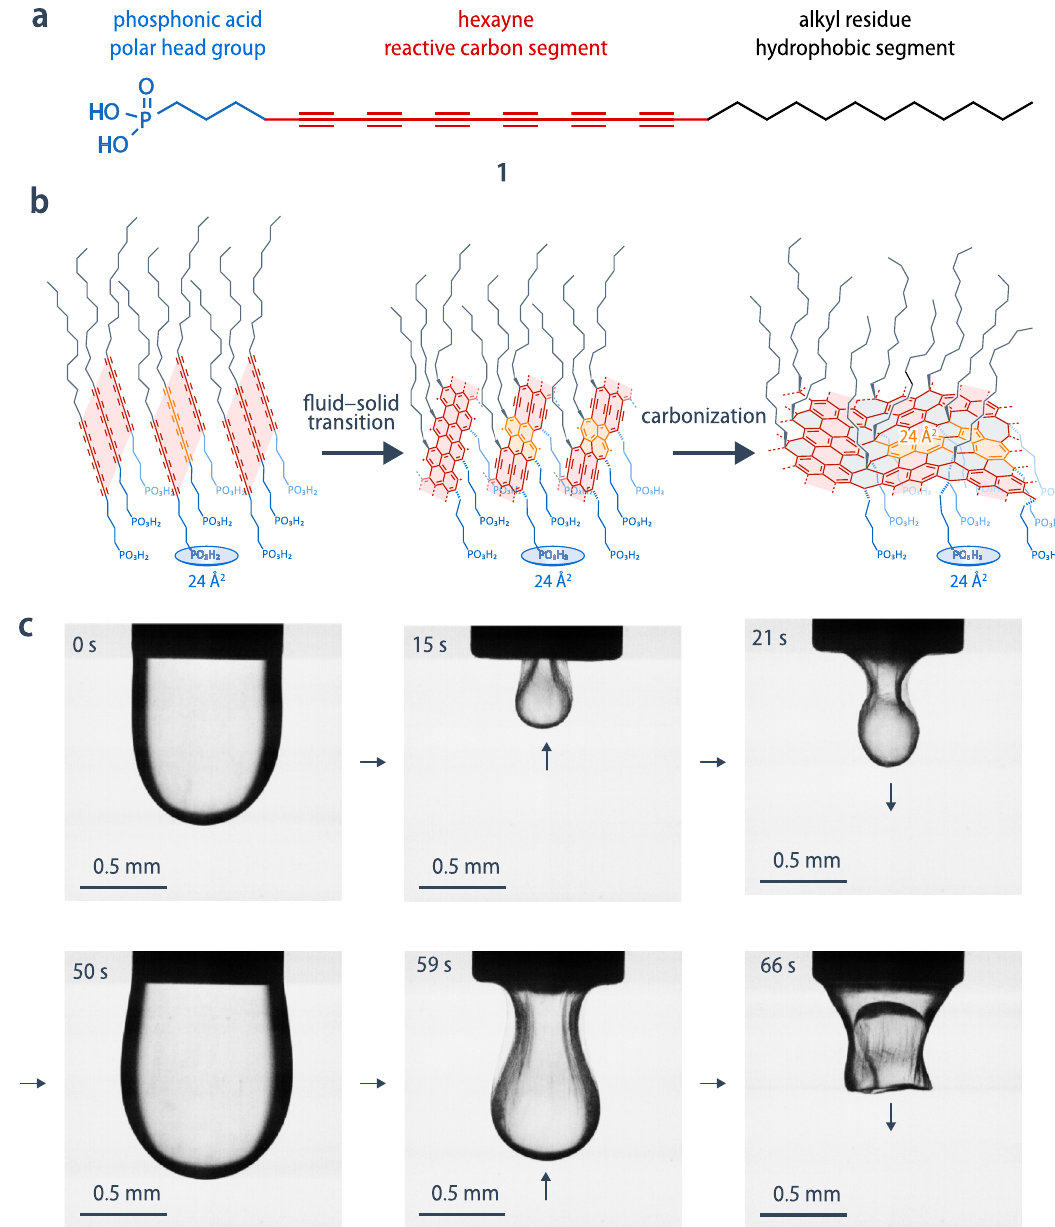
Fig. 1 The fl uid-solid transition at the interface. a Molecular structure of the carbon-rich surfactant 1 (octacosa-5,7,9,11,13,15-hexayne phosphonic acid) used for the spontaneous formation of the carbon nanoskin. b Illustration of the proposed interfacial carbonization of the surfactant 1 by 2D polymerization of the twelve hexayne carbon atoms via a cross-linked poly(ene-yne) to the fi nal amorphous carbon monolayer constituted of different C 12 “ carbon tiles ” whose average size is similar to the mean molecular area of the densely packed phosphonate groups. c Macroscopic wrinkles appear upon de fl ation of a droplet of a chloroform solution of surfactant 1 in water, revealing the solid nature of the formed membrane. The macroscopic droplet can be held in place by the nanoskin, re-in fl ated back to its original shape, and de fl ated once as a function of the relative surface-area change, 1 (cid:2) A = A , show surface concentration, 0 that, with increasing surfactant concentration, c , and assembly Γ ¼ ð (cid:1) γ (cid:2) γ Þ = K ð 6 Þ time, t , an ever-smaller relative reduction in area is necessary to 0 0 affect the transition from a fl uid interface formed from a molecular surfactant ( χ = 0) to a solid skin ( χ = 1) (Supplemen- according to the approximation of a simpli fi ed Gibbs isothermal tary Fig. 6). We de fi ne the onset of this fl uid-solid conversion at law, where K = 1.19 (±0.04) × 10 6 mN m mol – 1 is the chemical , as the intersection between the the critical surface area, A potential of surfactant 1 , which we have determined by fi tting the c tangent at the highest slope of χ and the χ = 0 axis (Fig. 2b). The diffusion-controlled regime of the interfacial concentration after key parameter governing the mechanical behavior of the drop measuring the diffusion coef fi cient by 2D DOSY NMR spectro- upon de fl ation is the surface tension of the drop immediately scopy (Supplementary Fig. 7, Supplementary Information, , which is linked to the initial surfactant before de fl ation, γ Section 1.4). 0